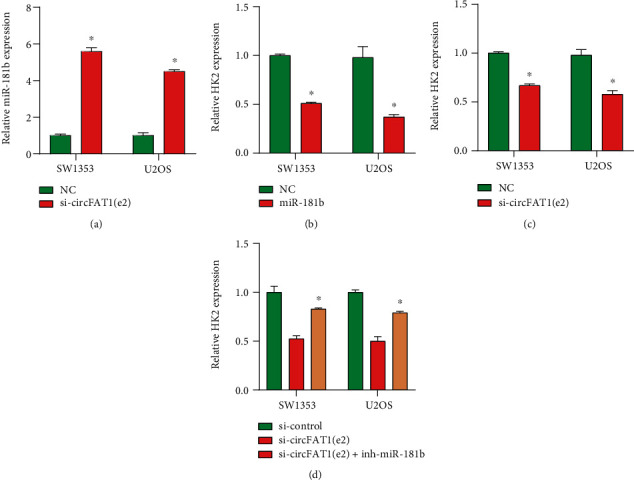
CircFAT1(e2) regulated HK2 expression by miR-181b. (a) qRT-PCR analysis for miR-181b expression in SW1353 and U2OS cells transfected with si-circFAT1(e2). (b) Overexpression miR-181b reduced the expression of HK2. (c) qRT-PCR analysis for HK2 expression in OS cells with si-circFAT1(e2). (d) The HK2 expression in SW1353 and U2OS cells with different treatment. Error bars represent the mean ± SD of at least three independent experiments. ∗p < 0.05, ∗∗p < 0.01 vs. control group.